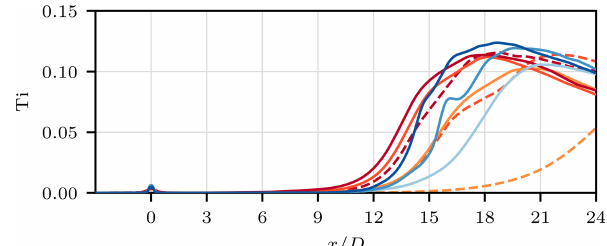
Figure 9. Stream-wise evolution of the turbulence intensity Ti at r/D = 0 . 625 in the CLBM and NS cases. For the legend, see Fig. 5. Additional dashed lines refer to AllOne CLBM results. These briefly illustrate the impact of the increased order of accuracy when using the parameterized relaxation rates of the CLBM on the wake